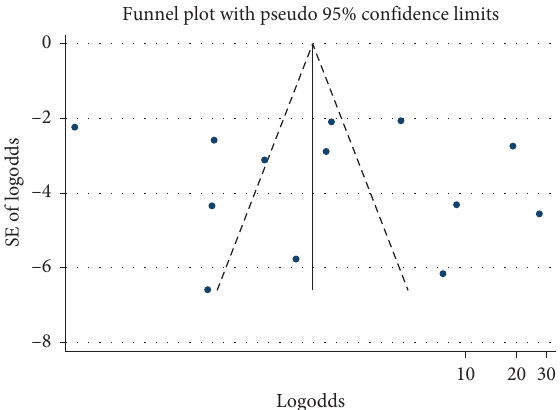
Figure 12: Funnel plot for publication bias of pooled prevalence of CPAB in Africa from 2007 to 2017 G.C.